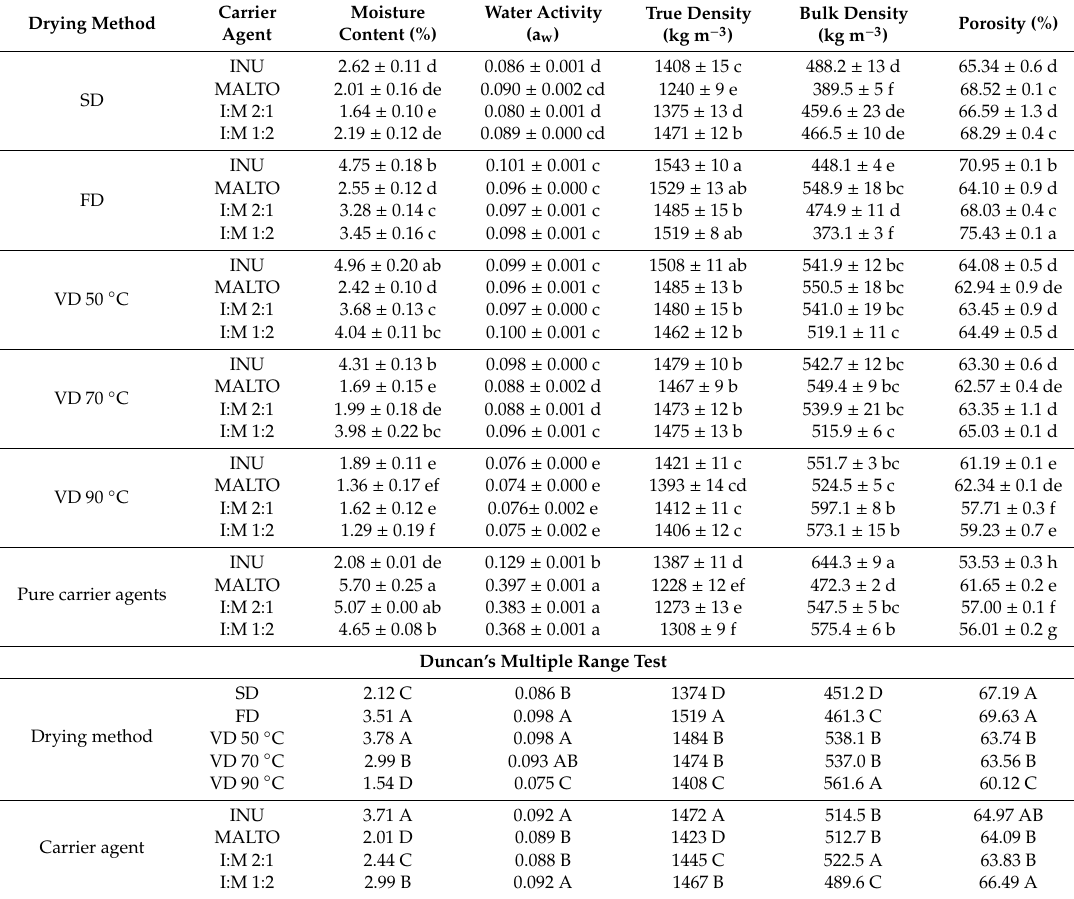
Table 1. Moisture content, water activity, true density, bulk density and porosity of sea buckthorn juice